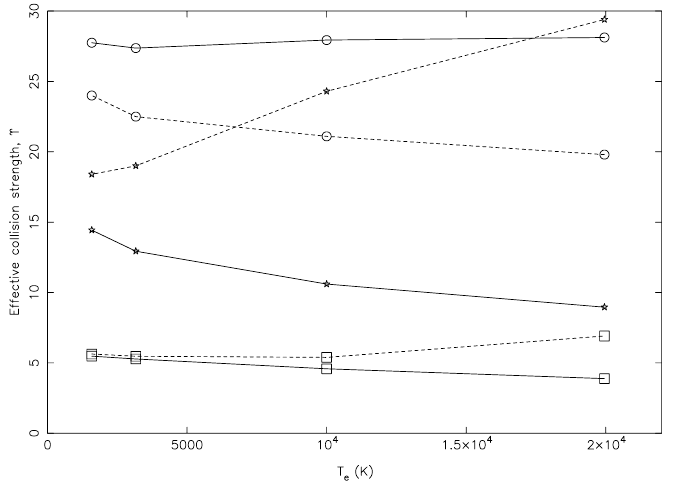
Figure 9. Comparison of effective collision strengths for the 7–14 (squares: 3d 2 D 3/2 –4d 2 D 5/2 ), 10–15 (circles: 4p 2 P o –4f 2 F o ) and 11–15 (stars: 4s 2 S 1/2 –4f 2 F o 1/2 5/2